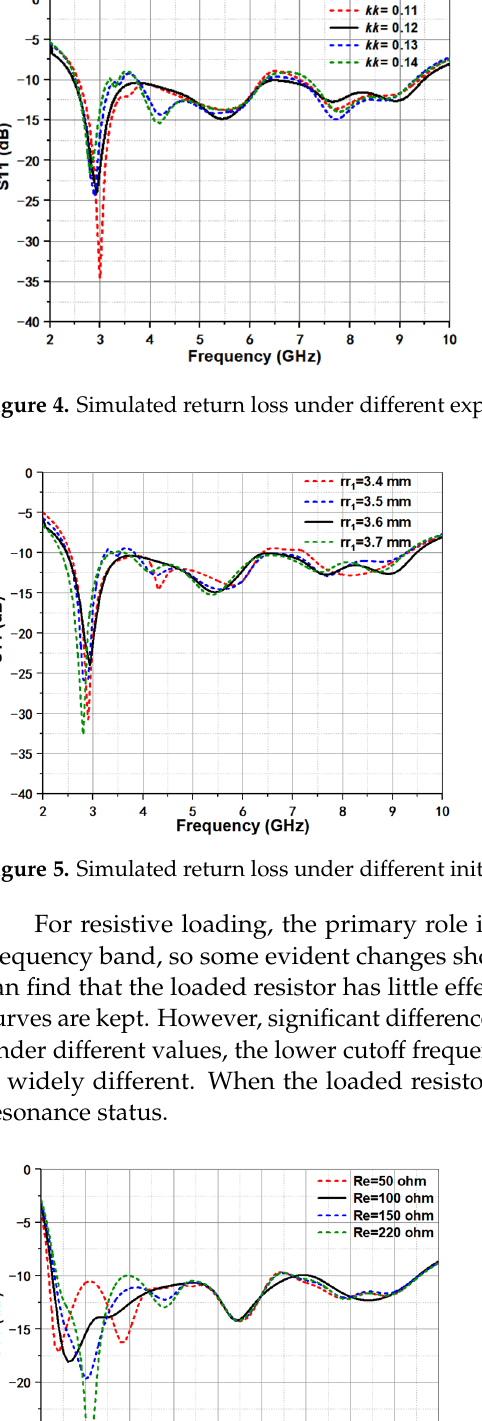
Figure 6. Simulated return loss under different loaded resistors.